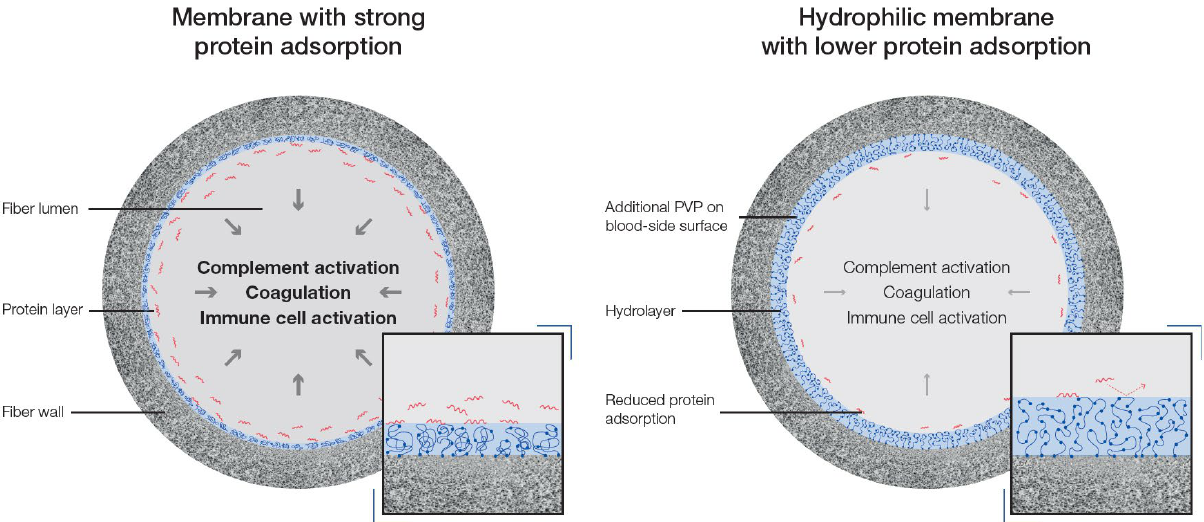
Figure 2. Schematic illustration of complement activation, coagulation and immune cell activation by a membrane with strong protein adsorption as compared to a hydrophilic membrane with lower protein adsorption. Increase in hydrophilicity can be achieved by an increased content of the hydrophilic agent polyvinylpyrrolidone (PVP) on the blood-side surface of the membrane, which reduces protein adsorption via repulsive hydration force of the formed water layer. Protein binding to the membrane leads to conformational changes or denaturation of protein structures which can subsequently trigger complement activation, coagulation, and immune cell activation.